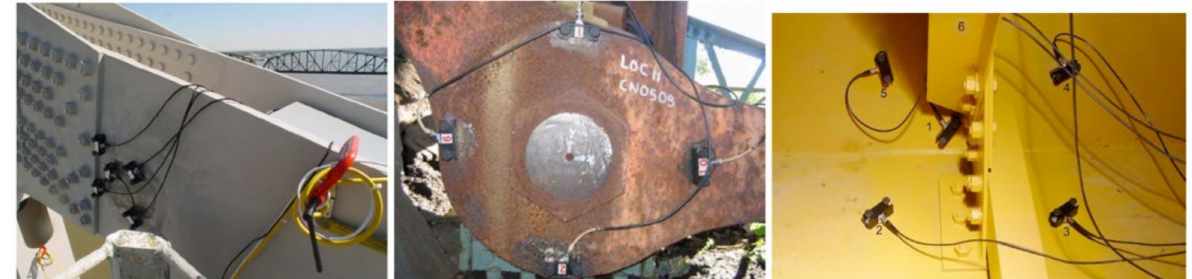
Figure 16. Application of AE for steel bridges [10,40,41].